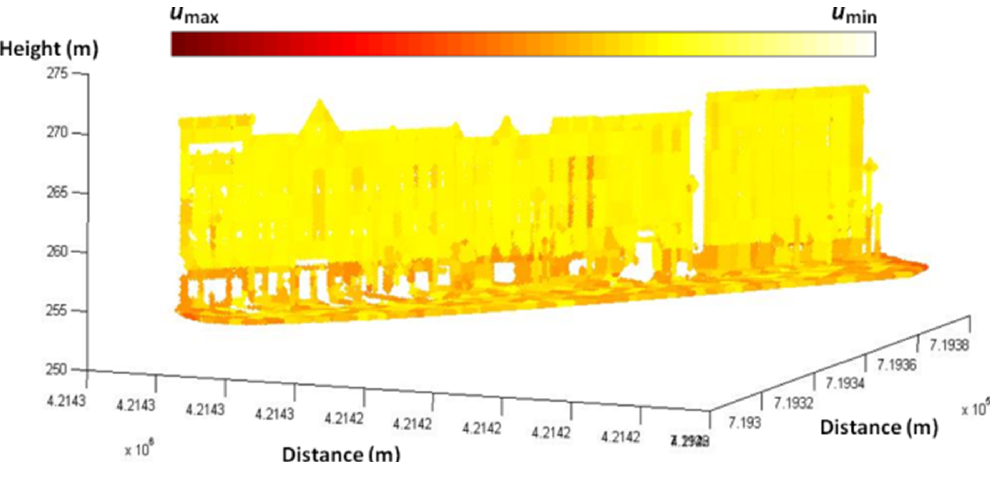
Figure 8. Uncertainty distribution map of the busy neighborhood-1 presented in the form of a color-coded heat map (with yellow being the lowest and red the highest level of